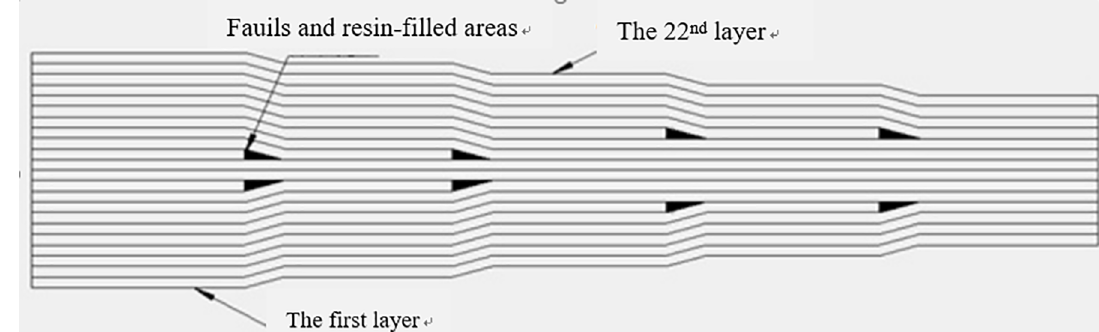
Figure 3. Schematic Diagram of Dropping Layering of CFRP Variable Thickness